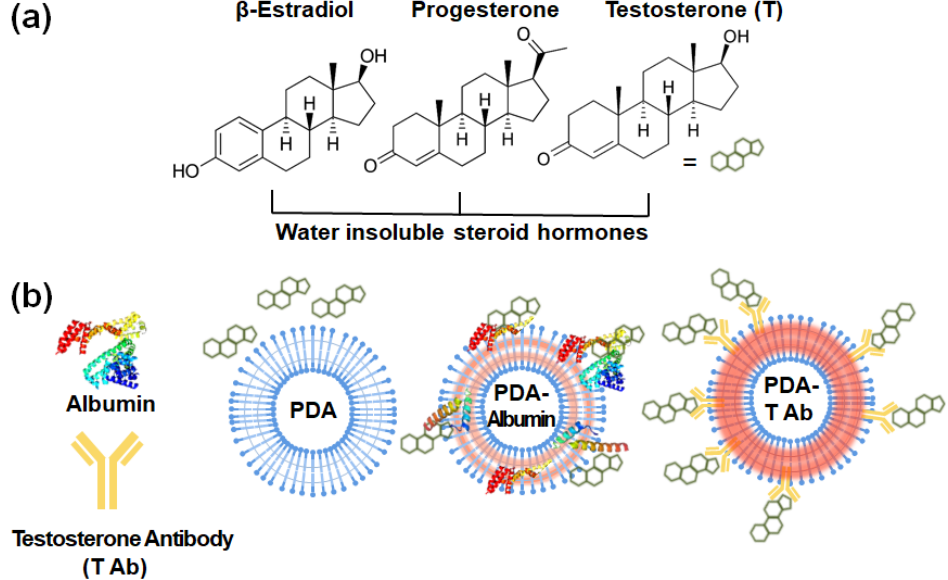
Figure 1. ( a ) Chemical structure of three sex steroid hormones ( β -estradiol, progesterone, testos- terone (T)) used as preterm biomarkers. ( b ) Schematic scenario of interaction of T on three types of polydiacetylene assemblies; liposome consisting of 10,12-pentacosadiynoic acid monomers (PDA), albumin-conjugated PDA (PDA-Albumin), and anti-T antibody-conjugated PDA (PDA-T Ab), when incubated with T. Depending on the interaction of T and PDA assemblies, colorimetric and fluorogenic sensory signal (red color) generated was drawn in the middle of the PDA assemblies.